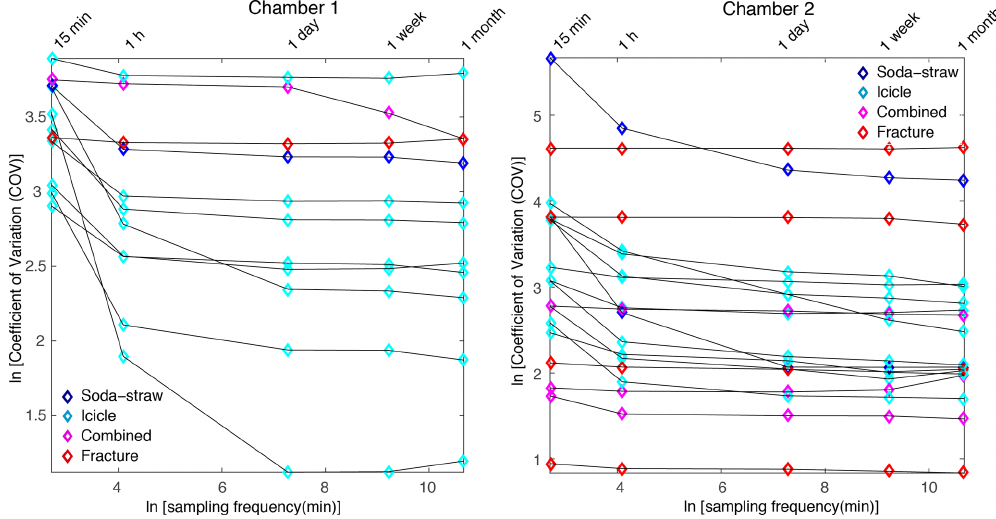
Figure 2. Optimum sampling frequency that minimizes sampling artifacts while maximizing the capture of natural